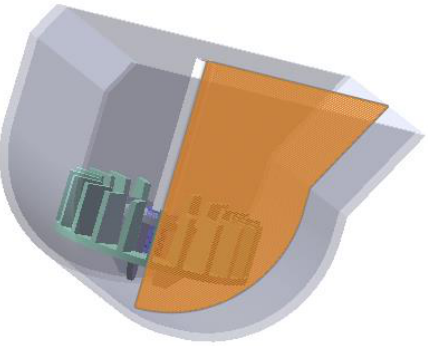
Figure 2. Schematics of the KYF (Kuang Yuan Flotation) flotation machine and impeller with rele- vant dimensional details.